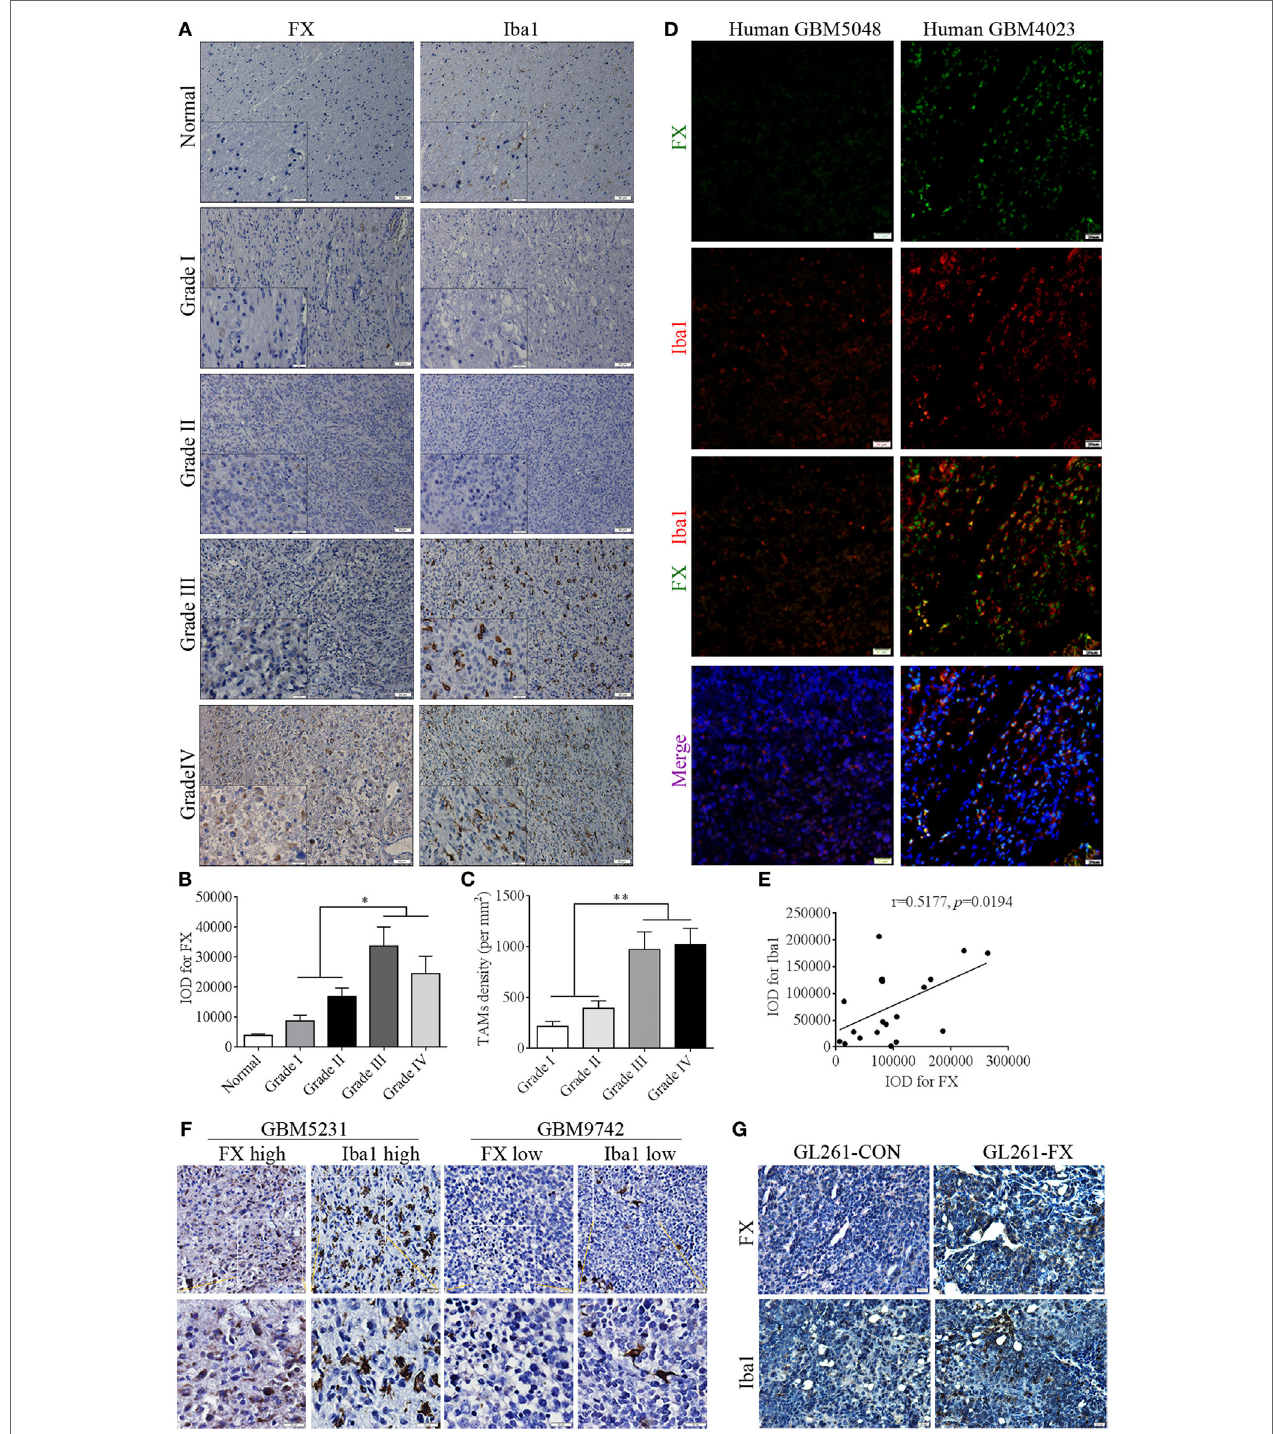
FigUre 2 | Factor X (FX) expression was positively correlated with tumor-associated macrophage (TAM) density in human glioblastoma multiformes (GBMs). (a) Immunohistochemistry showed the positive correlation between FX and the TAM marker Iba1 (red) in human normal brains ( n = 21) and astrocytoma of different WHO grades. Grade I ( n = 15); grade II ( n = 22); grade III ( n = 21); and grade IV ( n = 26). (B) The representative histogram of average IOD of FX in panel (a) . (c) The representative histogram of average number of TAMs per square millimeter in panel (a) . (D) Immunofluorescence analysis showed the positive correlation between FX (green) and Iba1 (red) expression in human GBM tissues ( n = 20). (e) The correlation analysis of IOD of FX and Iba1 in panel (D) . (F) Immunohistochemical staining showed that higher FX expression was accompanied by more TAM infiltration in consecutive paraffin sections of human GBM tissues ( n = 26). (g) Immunohistochemical staining showed there were more TAMs in GL261-FX-derived xenografted tumor than in GL261-CON